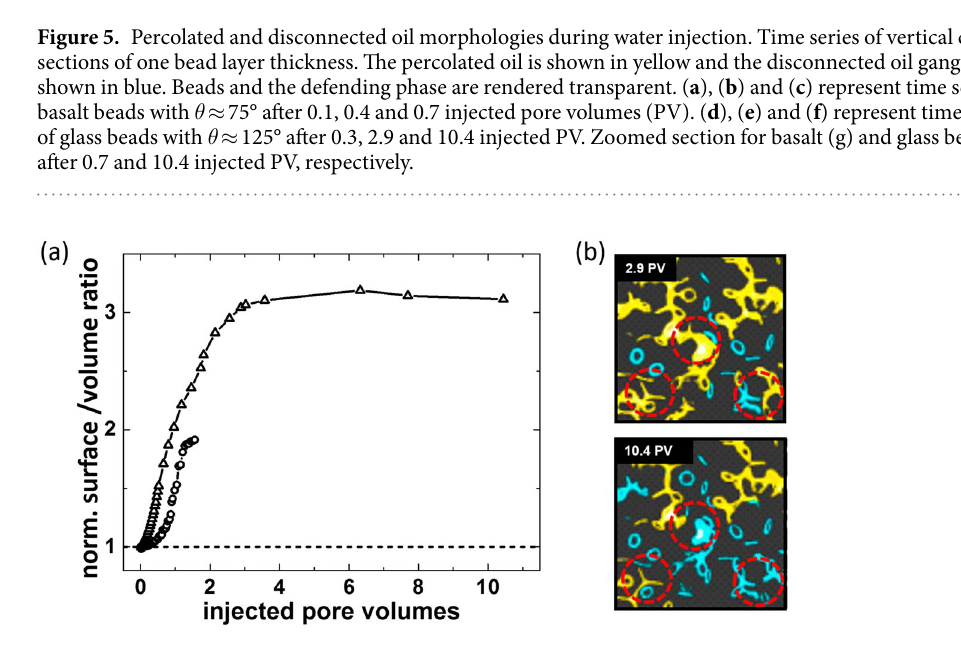
Figure 6a displays the surface–to–volume ratio a of the percolated subset of the defending phase normalized by the value a 0 for a random close pack of beads fully saturated with the defending phase. For the smaller contact angle of the invading phase (basalt θ ≈ 75°) the surface–to–volume ratio a remains small at a maximum value corresponding to about twice the surface–to–volume ratio a 0 as expected for compact morphologies in a random close packing of beads 38 . In the case of large contact angle (glass θ ≈ 125°, ramified morphology), we find an asymptotic value of a ∞ ≈ 3.3 a 0 of the surface–to–volume ratio for the percolated oil phase after injecting several pore volumes of the non–wetting invading phase (PV  5). This value of the surface–to-volume ratio is in fact close to the value reported for the liquid clusters of a wetting fluid in granular piles 38 . The large ratio a ∞ / a 0 is a consequence of the particular invasion process by which a non–wetting fluid displaces a wetting fluid from a permeable solid. During the fluid invasion at large contact angles, a percolated network of oil emerges, inter- twined with a dense network of fingers of the invading aqueous phase that have formed due to the frequent occurrence of Haines jumps. This network of the defending oil phase does not change qualitatively but quantita- tively upon further liquid injection. The network of defending phase is drained in the direction of flow, reducing its volume in the field of view, but hardly its surface area, finally leading to the asymptotic plateau value of a ∞ ≈ 3.3 a 0 , close to the value of the (de − ) percolation threshold. Upon further liquid injection, small liquid